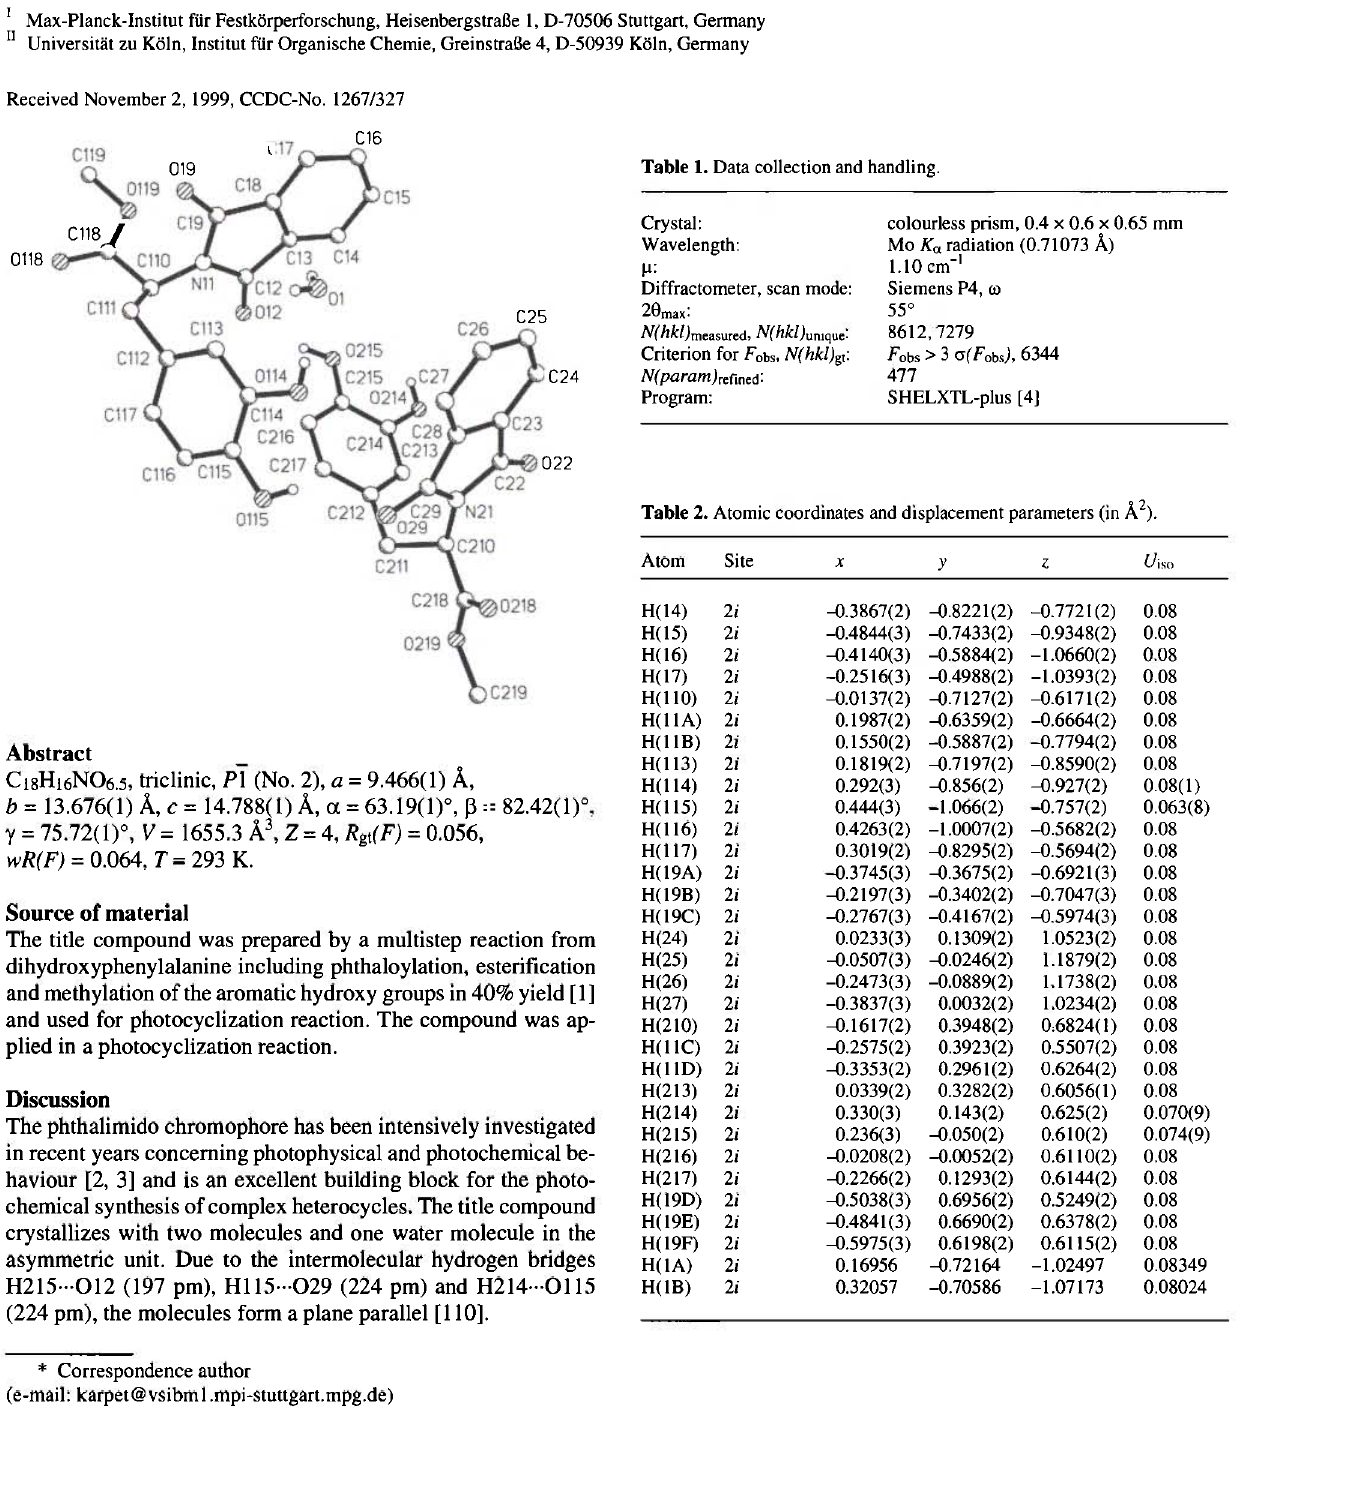
Table 1. Data collection and handling.